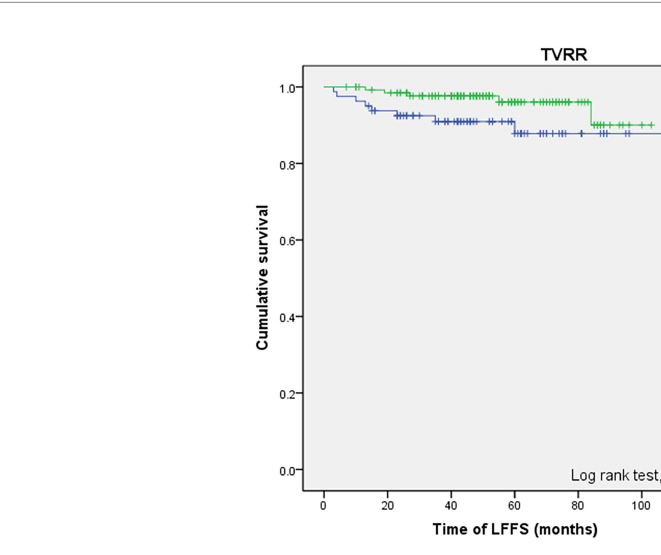
FIGURE 2 | LFFS-related prognostic factors: tumor reduction rate ( ≤ 82.19% vs > 82.19%).